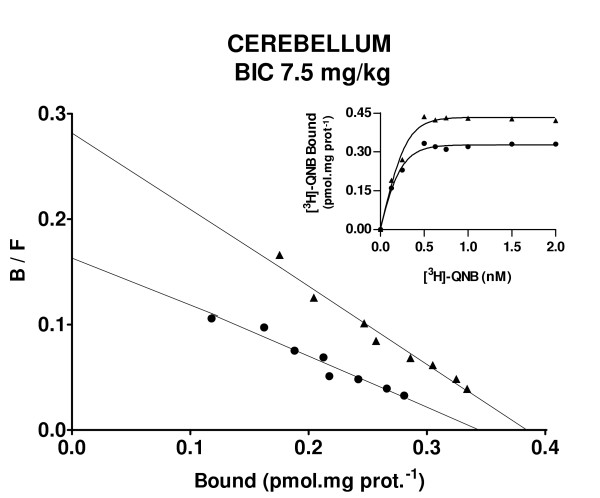
Scatchard plots for [3H]-QNB binding to rat cerebellar membranes at equilibrium after administration of a convulsant BIC dose (7.5 mg/kg). Results are from a single experiment representative of a set of three, each performed in duplicate. Inset, saturation curves. (●) Control; (▲) BIC seizure.